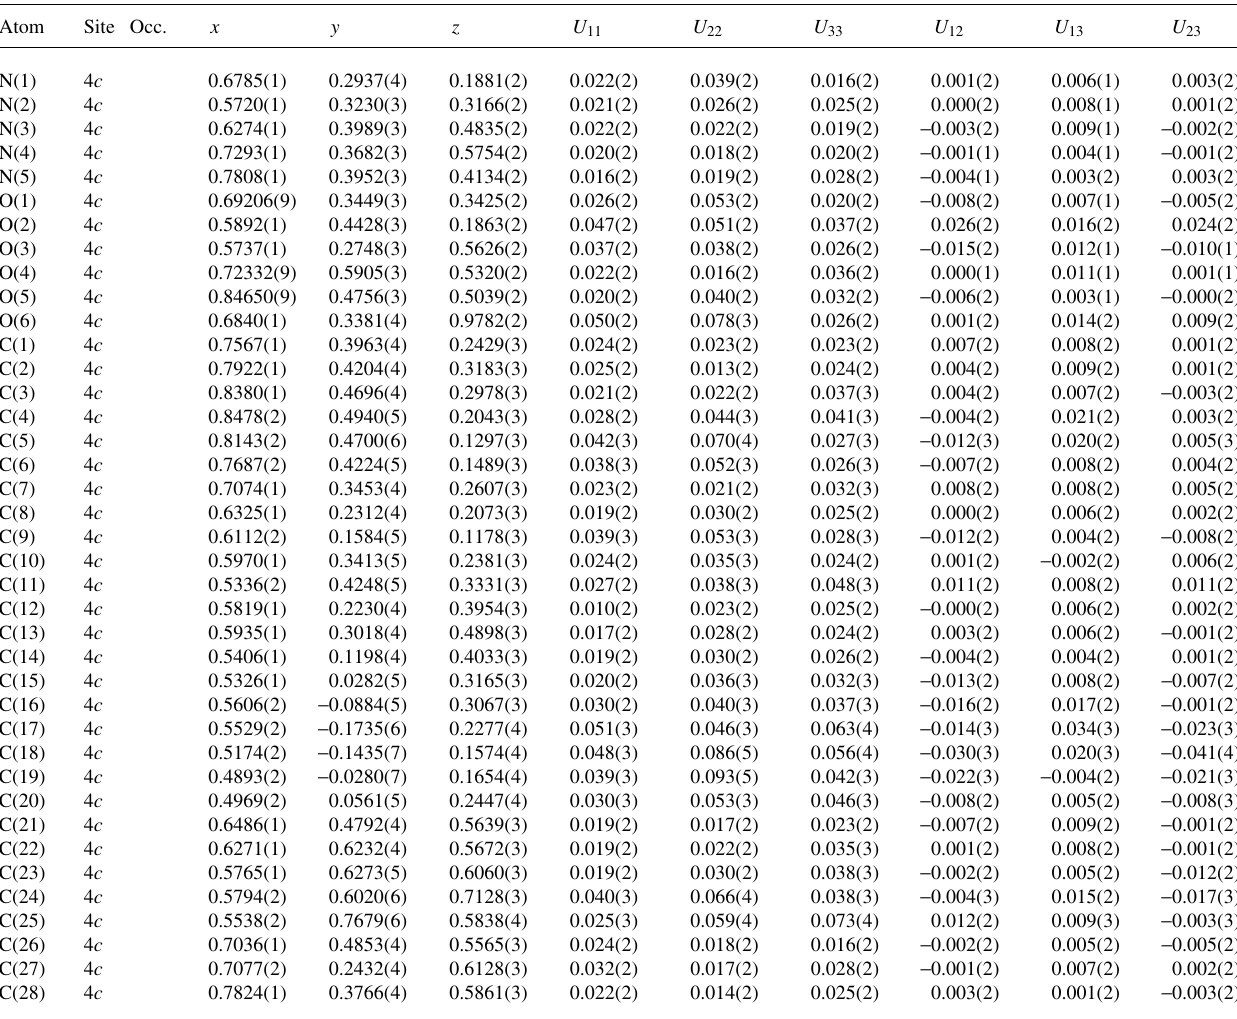
Table 3. Atomic coordinates and displacement parameters (in Å 2 ) .